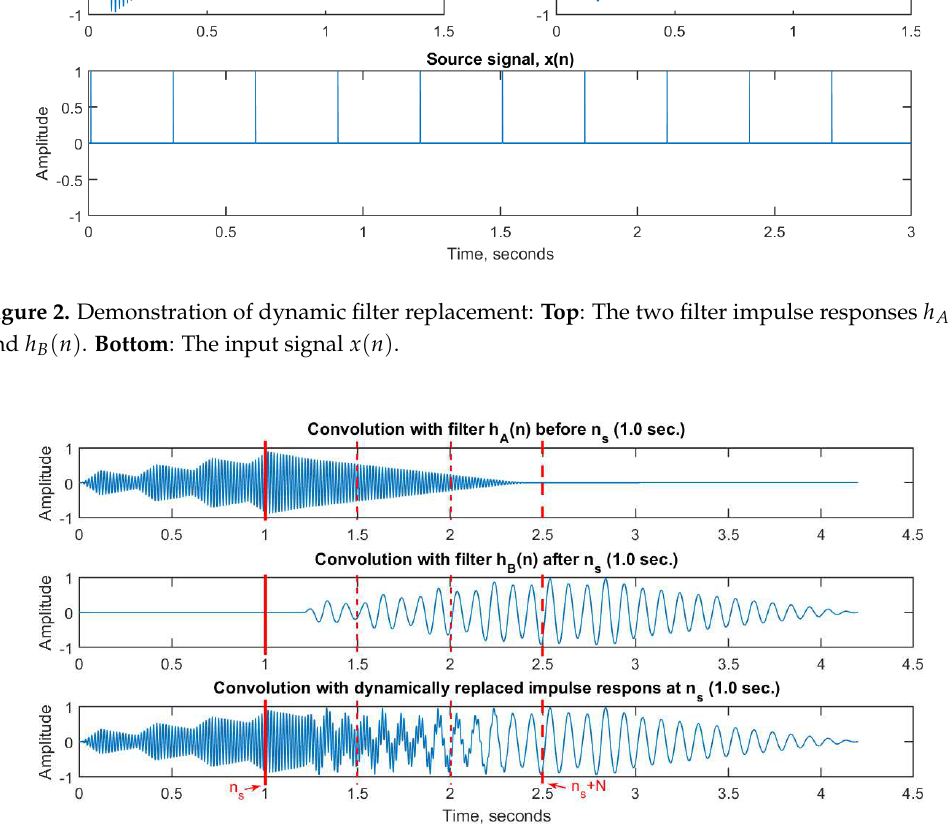
Figure 3. Demonstration of dynamic filter replacement. Top : The output from convolving the input x ( n ) with impulse response h A ( n ) before n s = 1 s Middle : The output from convolving the input x ( n ) with impulse response h B ( n ) after n s = 1 s Bottom : the output from convolving the input x ( n ) with h A ( n ) and its stepwise with h B ( n ) starting at n s = 1 s The vertical lines mark the time indices n s , n s + N /3, n s + 2 N /3, and n s + N in the transition